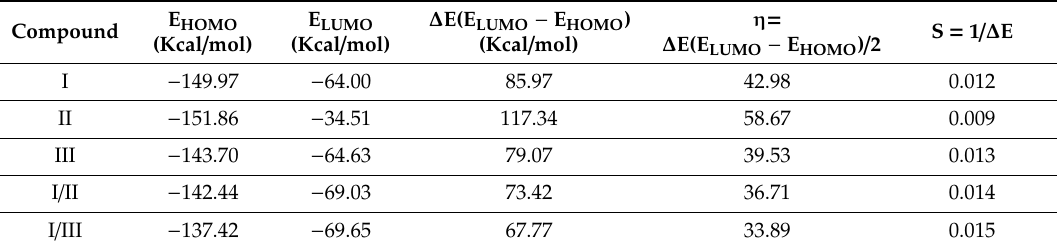
Figure 4. The calculated ground state isodensity surface plots for frontier molecular orbitals of ( a ) base I , acids ( b ) II and ( c ) III and their supramolecular complexes ( d ) I/II and ( e ) I/III ; ( ● ) C-atom; ( ● ) O-atom; ( ● )N-atom. Table 4. Molecular orbital energies, hardness ( η ) and global softness (S) of base I , acids II and III and their supramolecular complex I/II and I/III .